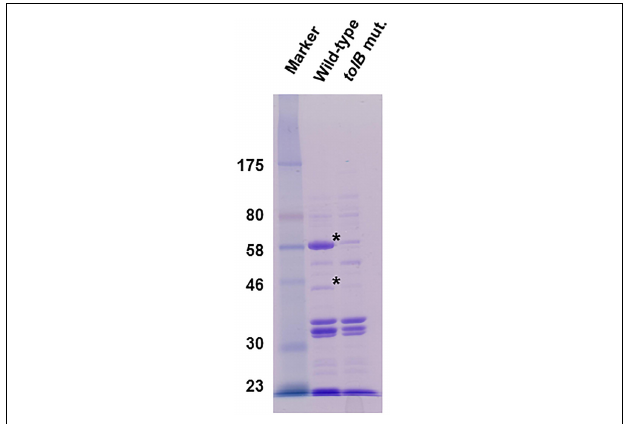
FIGURE 9 | SDS-PAGE of outer membrane proteins from the wild-type parent and the tolB mutant. Proteins were separated on a 10% acrylamide gel, and stained with Coomassie brilliant blue. Locations of molecular mass standards (in kilodaltons) are indicated on the left. Asterisks indicate protein bands which levels are remarkably low in the tolB mutant compared to the wild-type